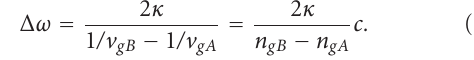
Figure 5: The transmission comparison for modified waveguides. δ = 0.2 a ( P II ) gives the highest peak transmission, indicating a sharp increase of coupling coe ffi cient. When δ = 0.3 a , coupling with higher-order even mode ( Q III ) comes into the frequency window.